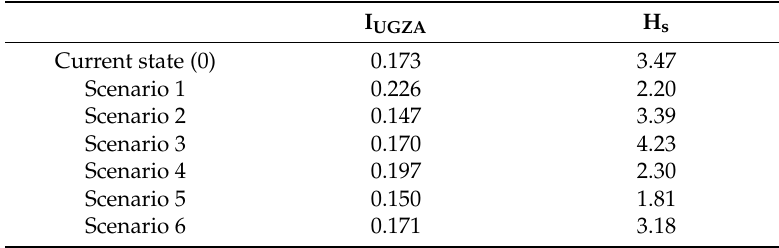
Table 3. Urban Green Zone Allergenicity Index (I UGZA ) for the current state of the urban park (0) and for current state and different planting scenarios and their corresponding Shannon index (H s